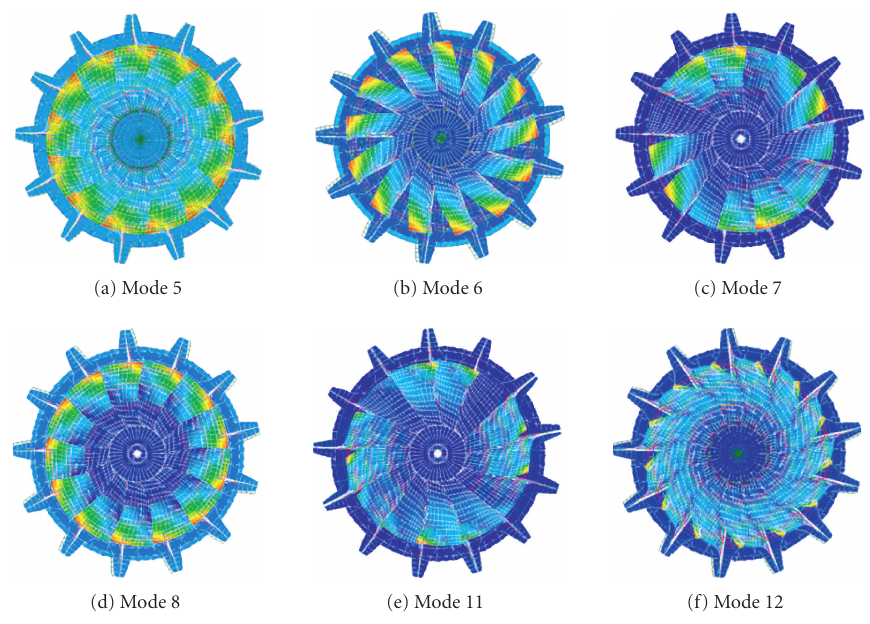
Figure 6: Blade bending modes of the turbine rotor shown in Figure 5.